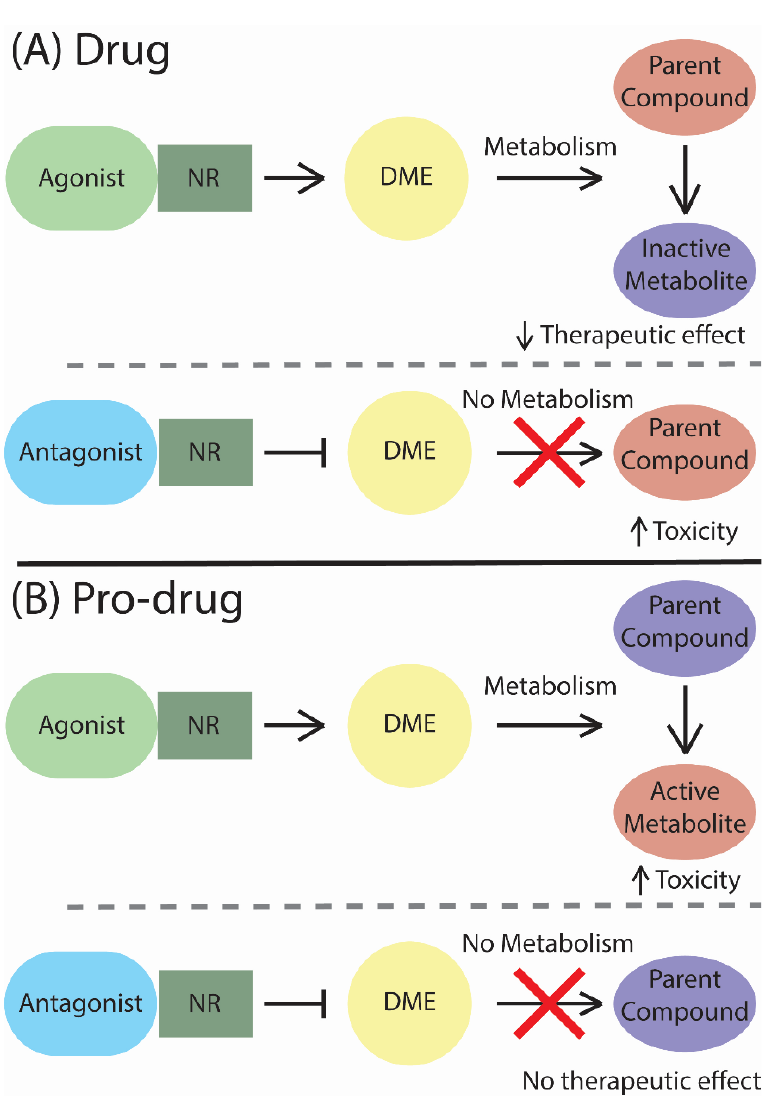
Figure 1. The metabolic scheme of drugs and prodrugs. ( A ) A nuclear receptor (NR) agonist activates the expression of drug-metabolizing enzymes (DMEs), leading to a decrease in activity of the drug, while an NR antagonist deactivates the expression of DMEs, keeping the drug active. ( B ) An NR agonist activates the expression of DMEs, leading to prodrugs becoming activated. An NR antagonist deactivates the expression of DMEs, keeping a prodrug inactive.